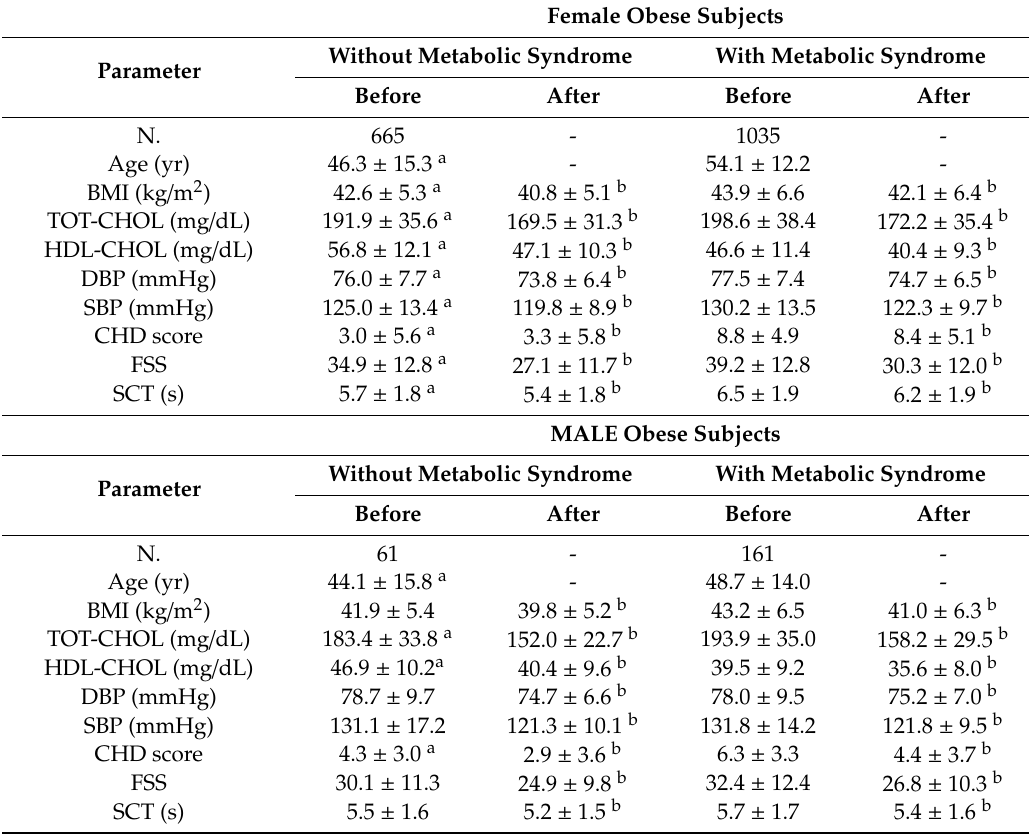
Table 2. Demographic, biochemical, and clinical characteristics of female and male obese subjects recruited in the study, subdivided into the two groups with or without metabolic syndrome, who underwent the 3-week